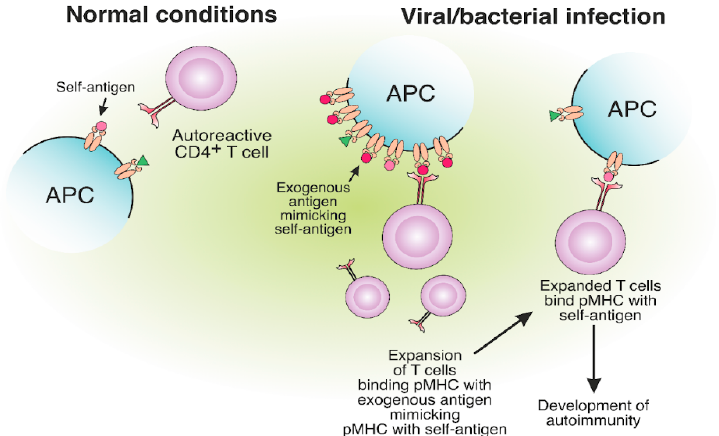
Figure 6. The expansion of autoreactive CD4 + T cells due to the molecular mimicry between foreign and self-antigens. The presentation of viral or bacterial antigenic peptides on MHC-II molecules, structurally similar to self-antigens, may result in the expansion of CD4 + T cells, specific to exogenous pMHC. Expanded CD4 + T cells, specific for foreign peptides, can bind the self-antigen pMHC, which results in the development of